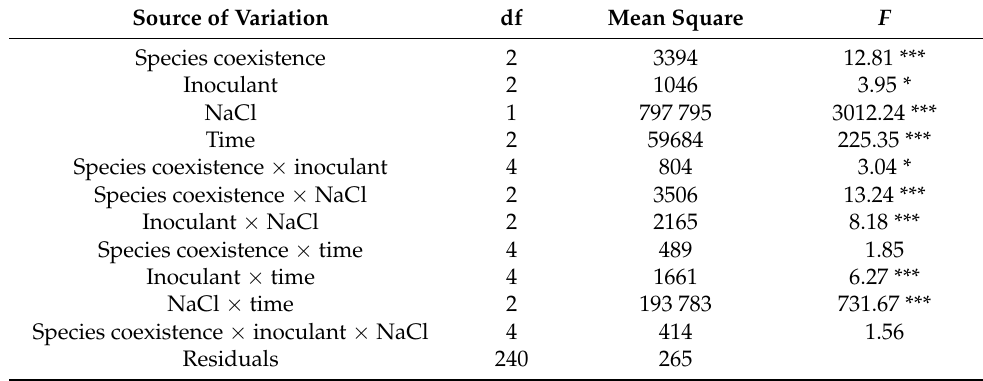
Table 3. ANOVA analysis of substrate electrical